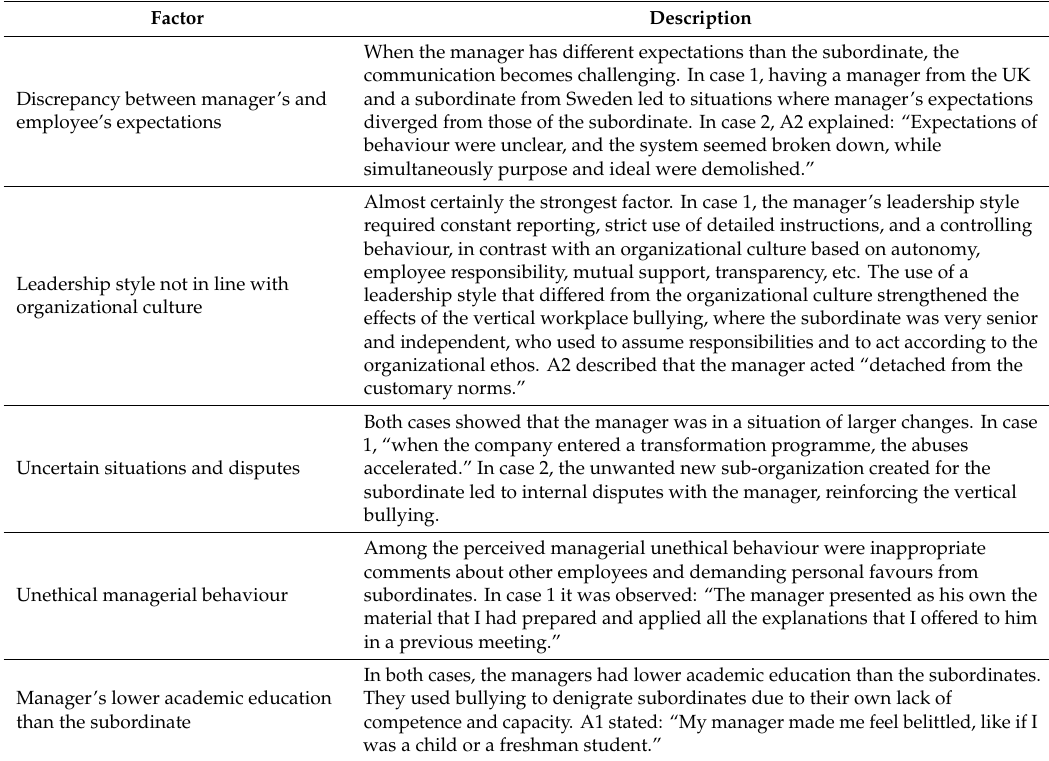
Table 5. Factors that reinforce